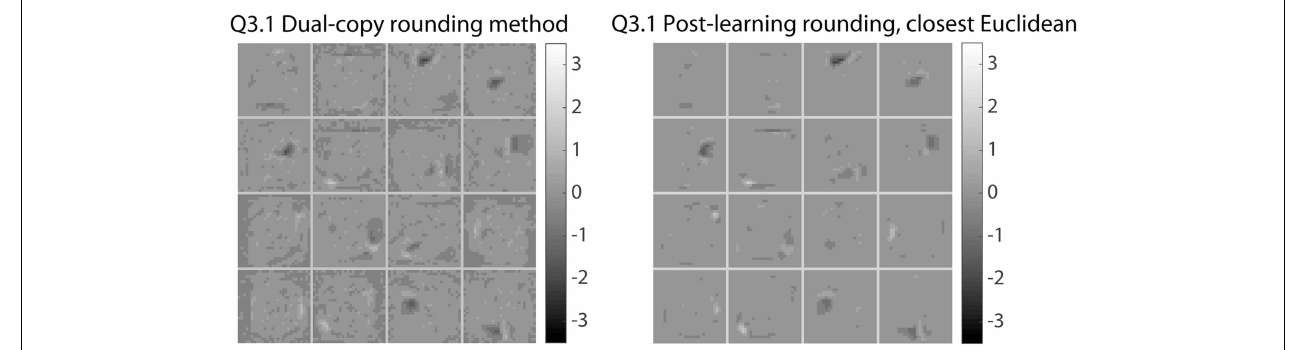
from the post-learning rounding weight matrix that are most similar to these chosen weights are displayed. The dual-copy rounding method is able to preserve much more fine structure, compared to simply rounding the network weights after training, and is thus more suitable for training networks that will be executed with lower bit precision